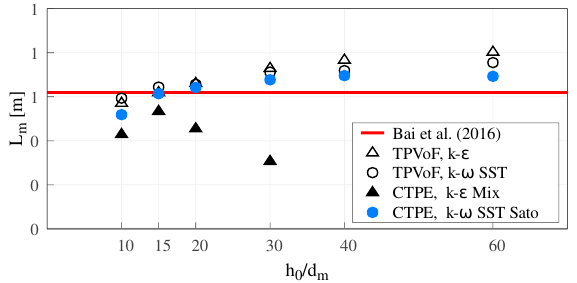
Figure 9. Maximum pressure increment location ( L m